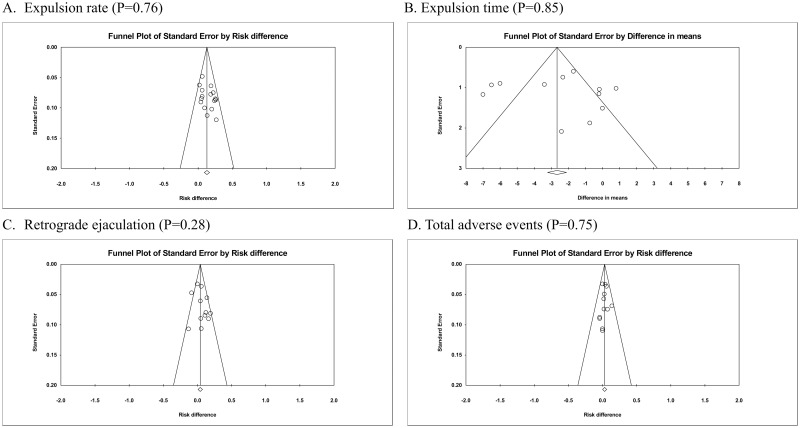
Funnel plots of comparisons of silodosin with tamsulosin.A: expulsion rate, B: expulsion time, C: retrograde ejaculation, and D: total adverse events.